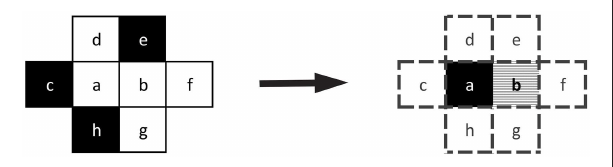
FIGURE 6 | An example transition for pair ab . Sites c through h are their nearest neighbors. (Left) At the beginning of the update step, the pair ab has the configuration [00], i.e., both are inactive, while three neighbors are active. (Right) At the end of the update step, the pair ab has the new configuration [11], via self-activation for site a and via recruitment for site b .